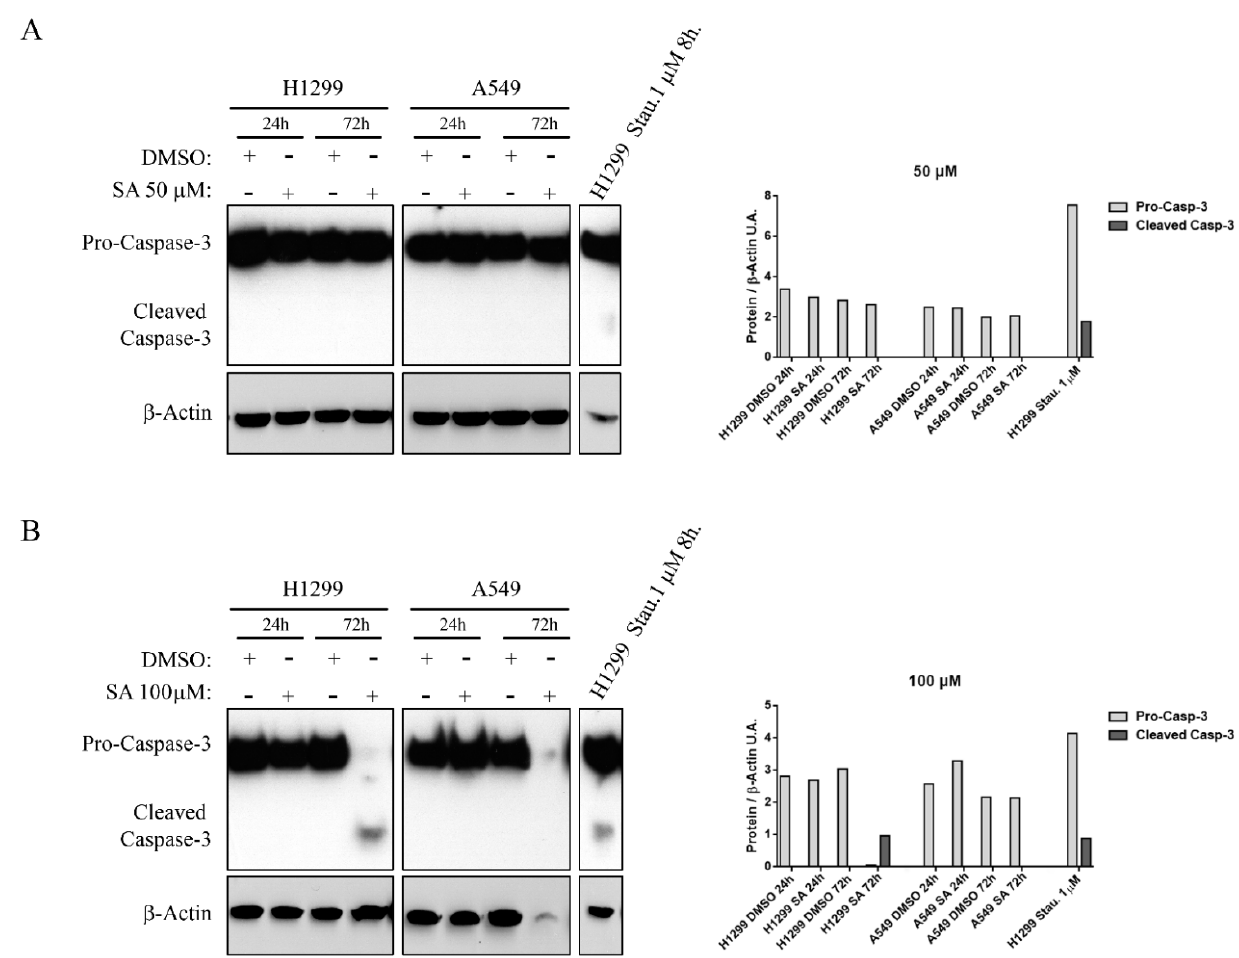
Figure 3. Caspase-3 apoptotic pathway participates in SA-induced cell death. Representative Western blot of Caspase-3 activation in protein extracts of H1299 and A549 cell lines and quantification of Western blot signal intensity (right graphics). Values represents the Pro-Caspase-3 or Cleaved Caspase-3 over β -Actin signal in UA. Staurosporine 1 µM treatment in H1299 for 8 h was used as positive control of Caspase-3 cleavage and apoptosis activation. ( A ) Caspase-3 levels after 24 and 72 h of 50 µM SA treatments. ( B ) Caspase-3 levels after at 24 and 72 h of 100 µM SA treatments.